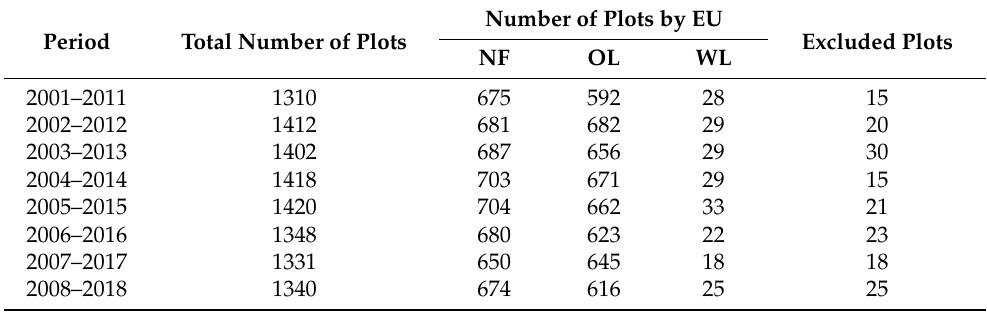
Table 2. The total number of FIA plots used in model fitting was reported by time period and Estimation Units (EU). The number of excluded plots, which were classified as water in all NLCD maps, are also reported. Estimation units were: National Forest lands not designated as wilderness areas (NF), National Forest lands designated as wilderness areas (WL), and other lands (OL). Number of Plots by Period Total Number of Plots